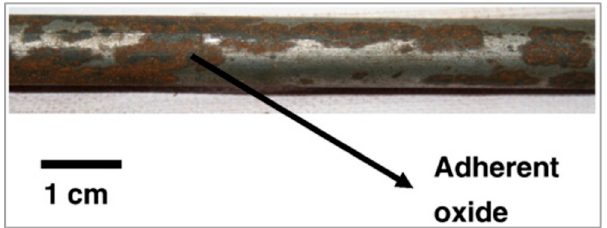
Figure 8. Photograph of a mechanically descaled wire rod showing adherent oxides. Reprinted with permission from ref. [15].